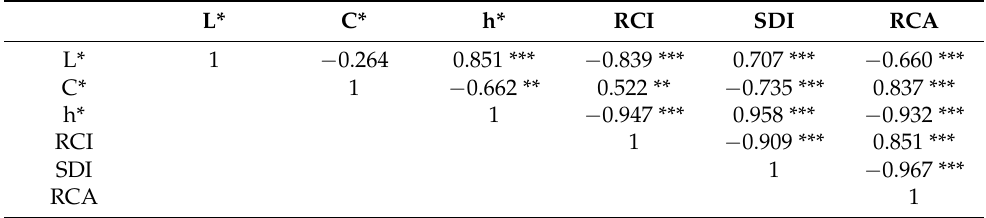
Table 4. Correlations between instrumental colour parameters (L*, C*, and h*) and the visual attributes (red colour intensity, surface discolouration intensity, and red colour acceptance) were evaluated by panellists in sensory analysis of pork patties. L* C* h* RCI SDI RCA L* 1 − 0.264 0.851